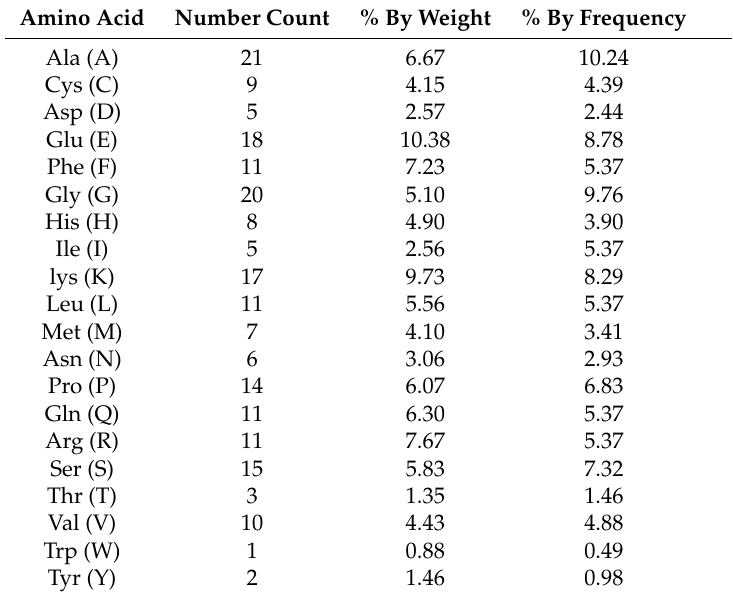
Table 3. Predicted chemical composition of the cLin-28